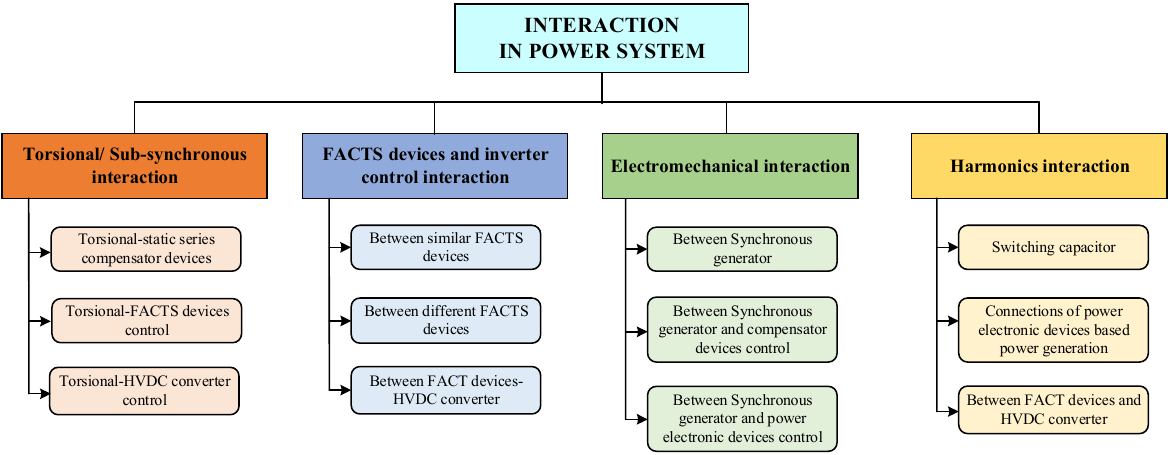
Figure 5. Interaction in power